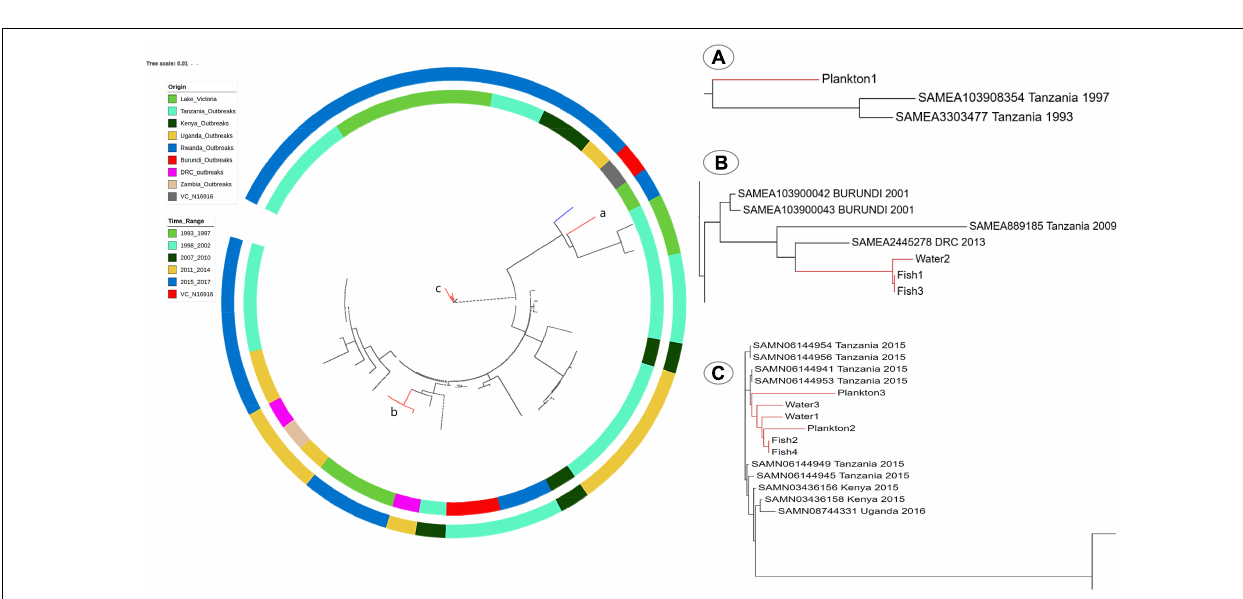
FIGURE 5 | SNP-Tree showing spatial-temporal phylogeny of environmental strains and pandemic V. cholerae from seven countries in the African Great Lakes Region. Colors on the inner lane indicate the origin of strains and the outer lane colors indicate the timeline evolution of the strains as shown in the legend. The tree was rooted with the reference V. cholerae N16916 (blue branch). Red branches identify the position of environmental genomes on the tree. (A) Localization of the strain Plankton1 in a clade of older strains involved in the initial waves of the seventh pandemic; (B) position of Fish1, 3 and Water2, and (C) a clade of recent outbreak strains in Tanzania, Kenya, and Uganda with most environmental